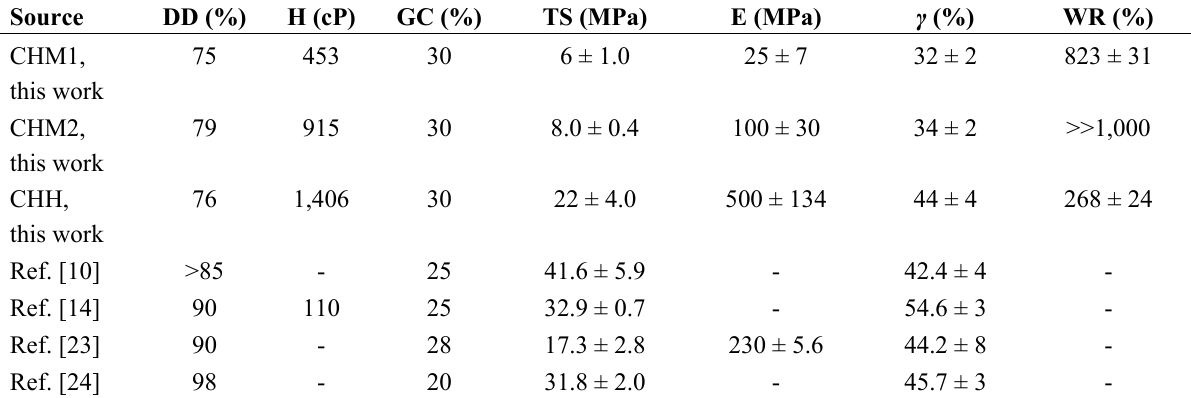
Table 2. Properties of films prepared using chitosan from various sources (Source). Chitosan degree of deacetylisation (DD), glycerine content by weight relative to chitosan (GC), tensile strength (TS), Young’s modulus (E), strain-at-break ( γ ) and water resistance (WR) for the different chitosan materials. “CHH” indicates high molecular weight chitosan, while “CHM1” and “CHM2” indicate two different batches of medium molecular weight chitosan,